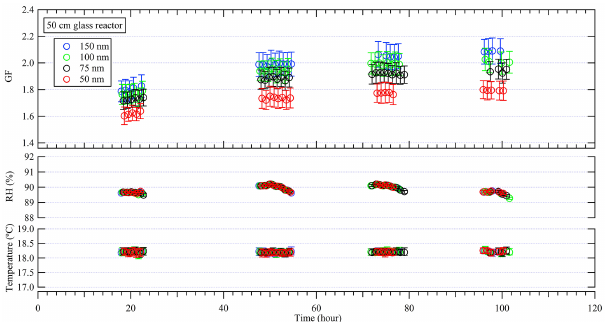
Figure 3. Time taken to achieve stable measurements in the HT- DMA system. Steady state was only attained after several days, af- ter which the GF remained constant for each organic